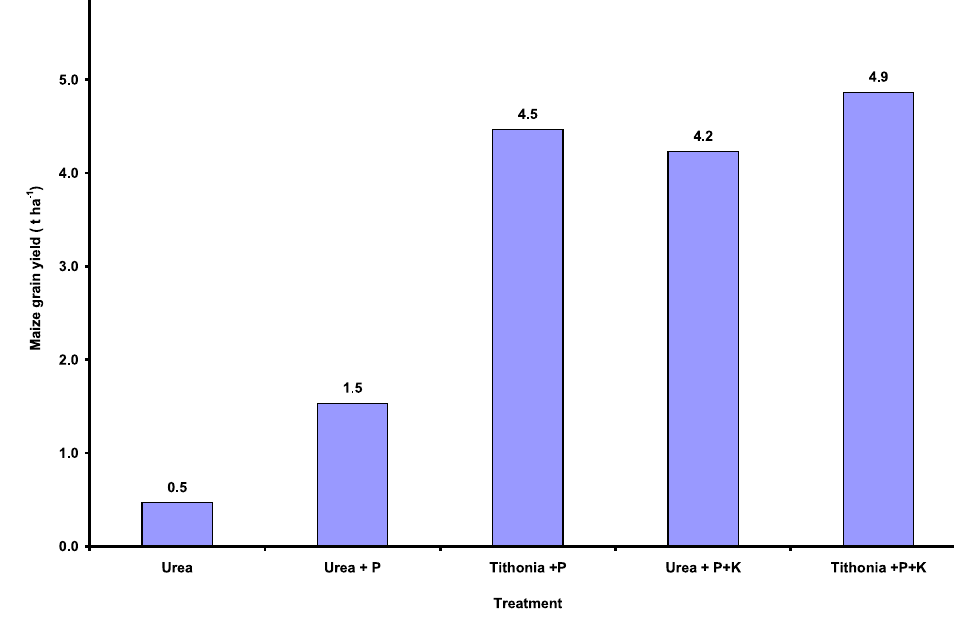
Fig. 2 – Effect of Tithonia green foliage as a source of N and K for maize compared with inorganic fertilizer when P is supplied to both at N, P and K deficient soil on six seasons average maize grain yield. Nitrogen and Potassium were applied at the rate of 60 kg ha -1 and P at 50 kg ha -1 in the first of the two seasons of each year (Source: Bashir Jama, unpublished data).